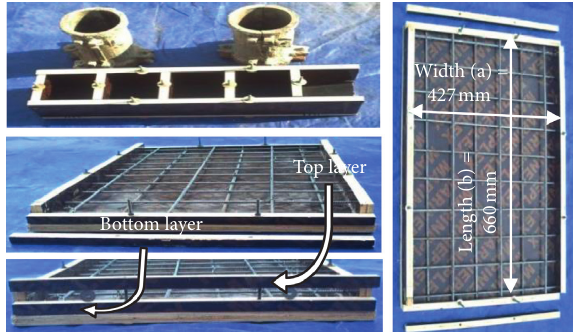
Figure 1: Details of the forms used for slabs, cubes, and cylinders.